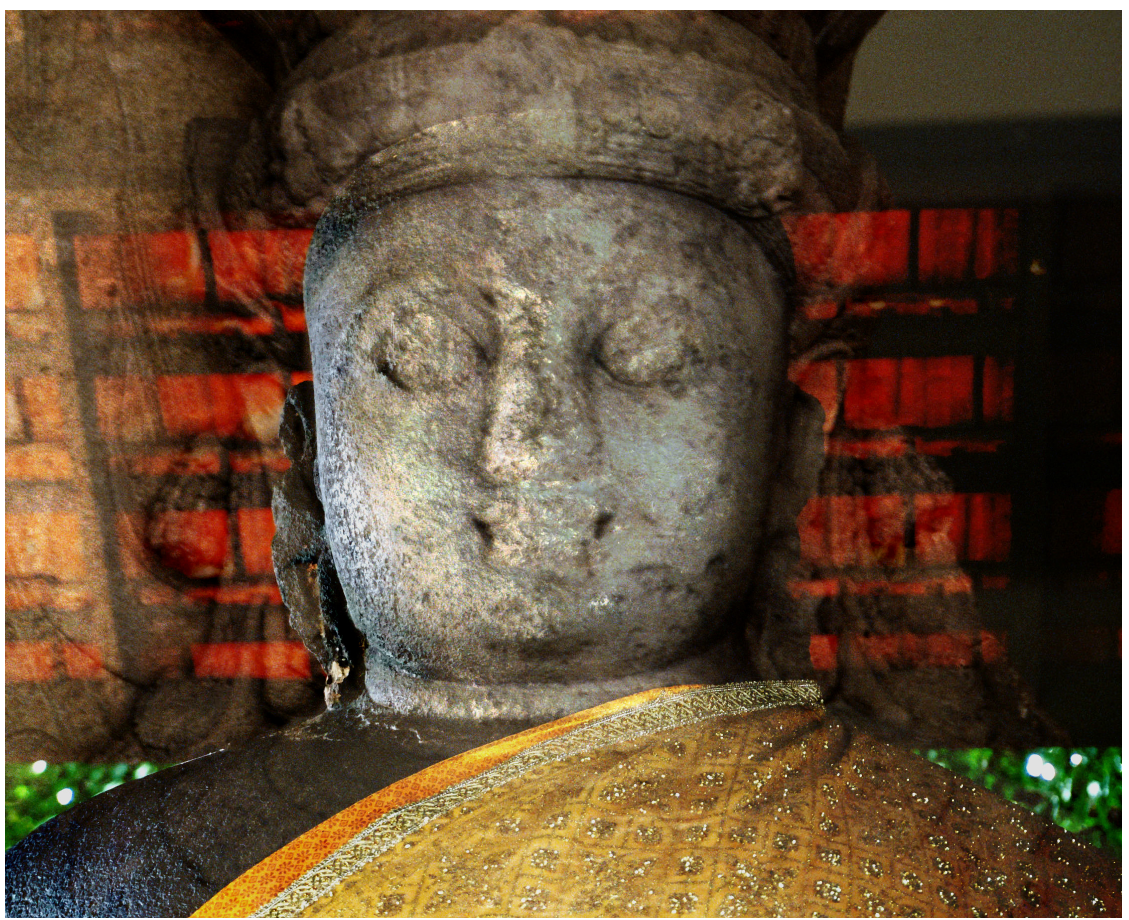
Figure 7 Superimposition of the faces of Joko Dolog and the monumental Vajramahākāla. Composite with 75% hard light layering. Source: author, 17 January